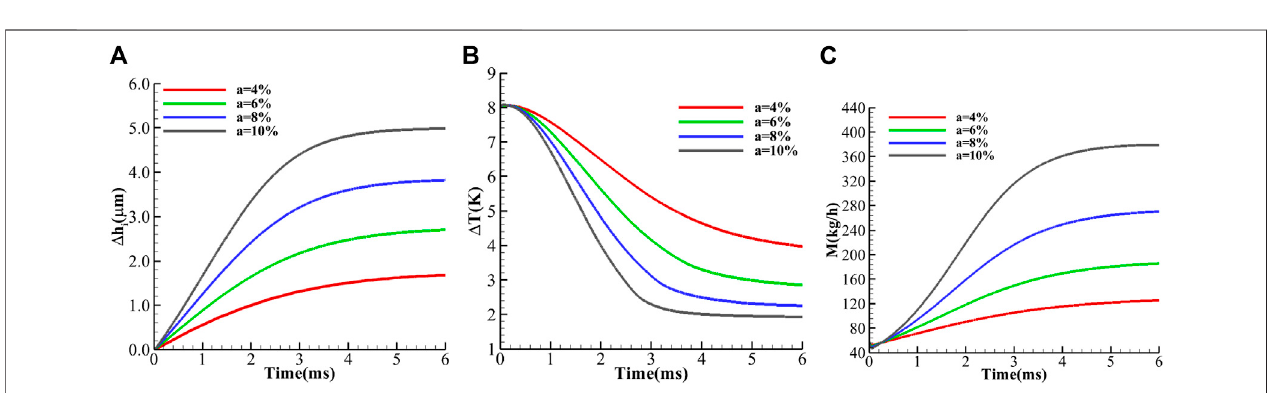
FIGURE 10 | Variation of parameters with time (A) static ring displacement, (B) inlet-to-outlet temperature difference, and (C) the leakage.